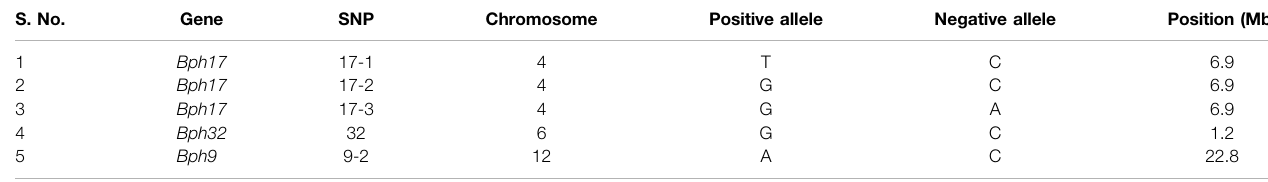
TABLE 4 | Analysis of variance for brown planthopper scoring of 83 rice genotypes and checks in augmented RCBD. Source of variation